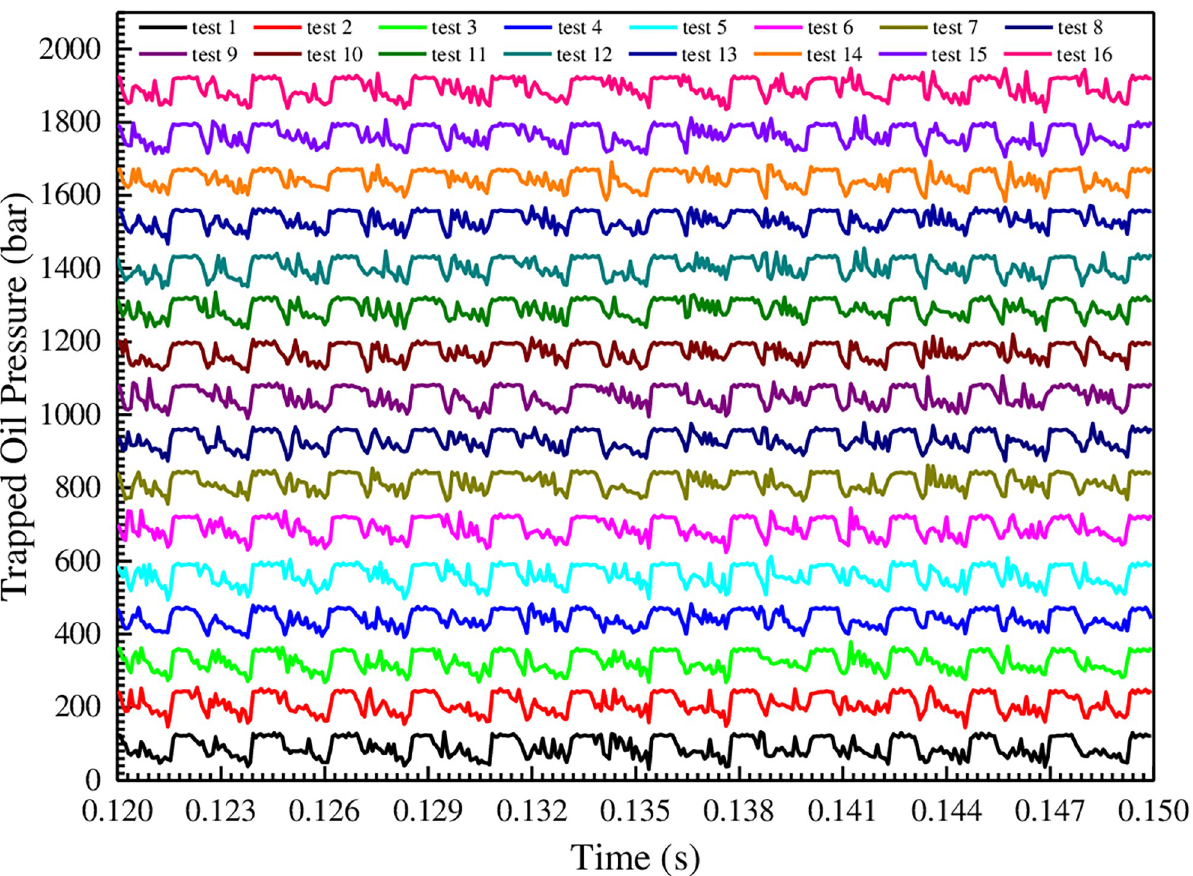
Fig 14. Comparison of trapped oil pressure curves under different test